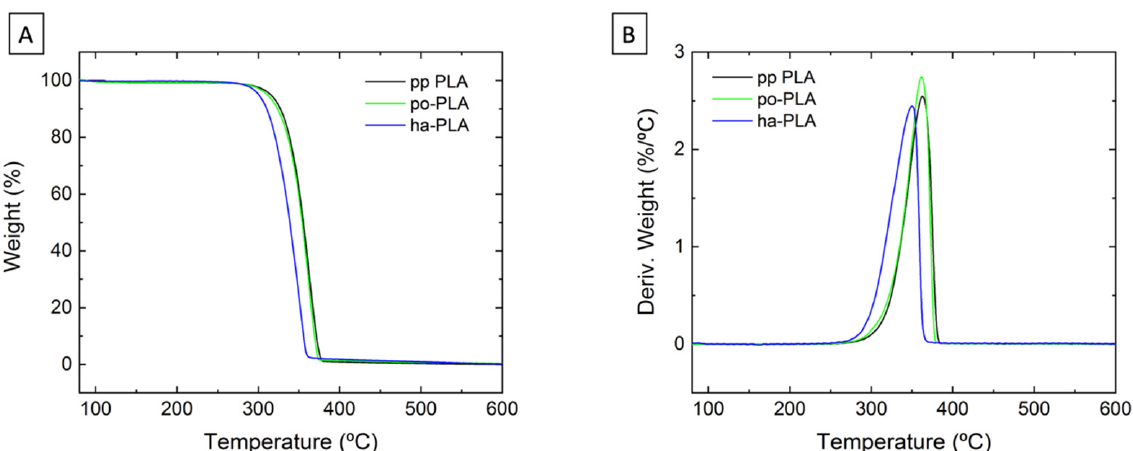
Figure 9. ( A ) Thermogravimetric analysis (TGA) thermograms of pp-PLA po-PLA and ha-PLA fibers at a heating rate of 10 °C/min performed under nitrogen atmosphere; ( B ) derivatives of TGA thermograms. Table 4. Degradation temperatures of onset and maximum peak of samples in an inert atmosphere. Errors in T ± 1 °C.